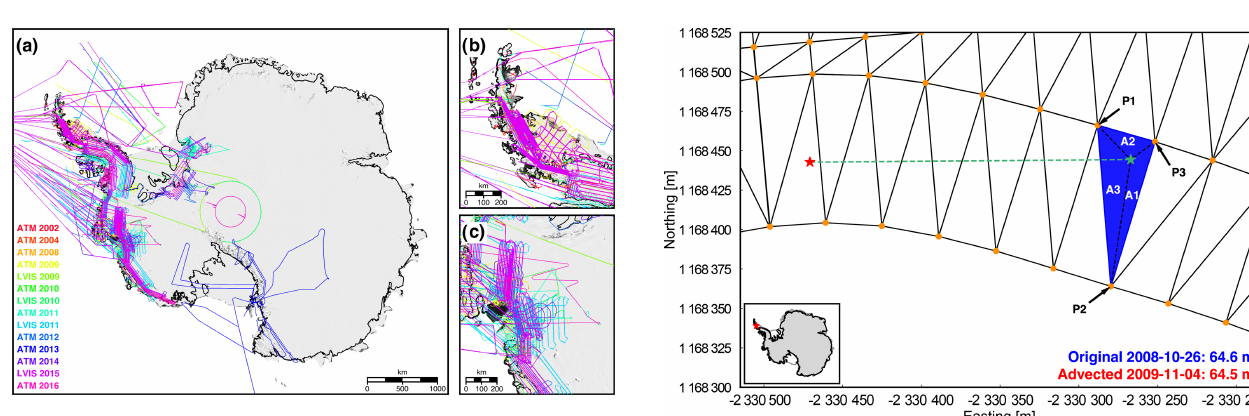
Figure 2. Triangulated mesh formulated around an advected 2008 ATM (Airborne Topographic Mapper) flight line point using points from a 2009 ATM flight line (orange dots). The red star denotes the location of the original point, the green star denotes the parcel location after advection, and the dashed green line is the path of advection. P1, P2, and P3 represent the three vertices of the triangle housing the advected ATM point. Elevation values at each vertex point are weighted in the interpolation by their respective areas, A1, A2, and A3. The inset map shows the location of the main